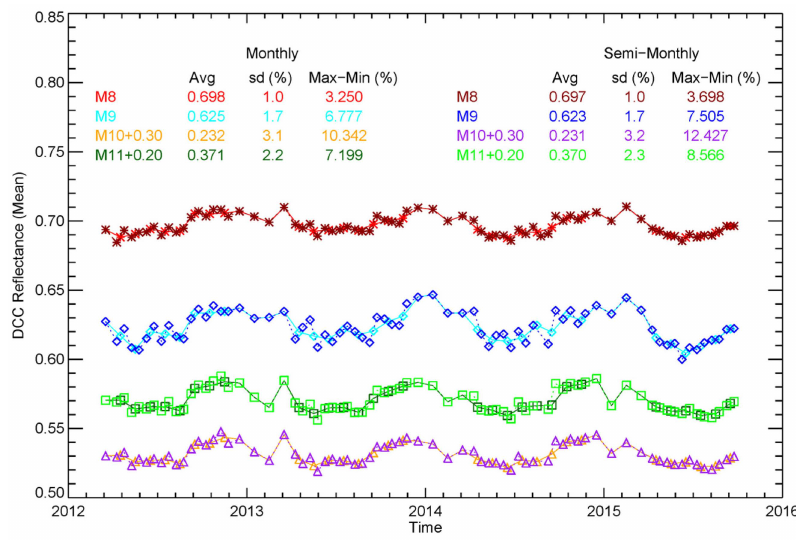
Figure 12. Comparison of monthly and semi-monthly DCC mean time series for SWIR bands M8-M11 (monthly DCC TOA reflectance mean time series were